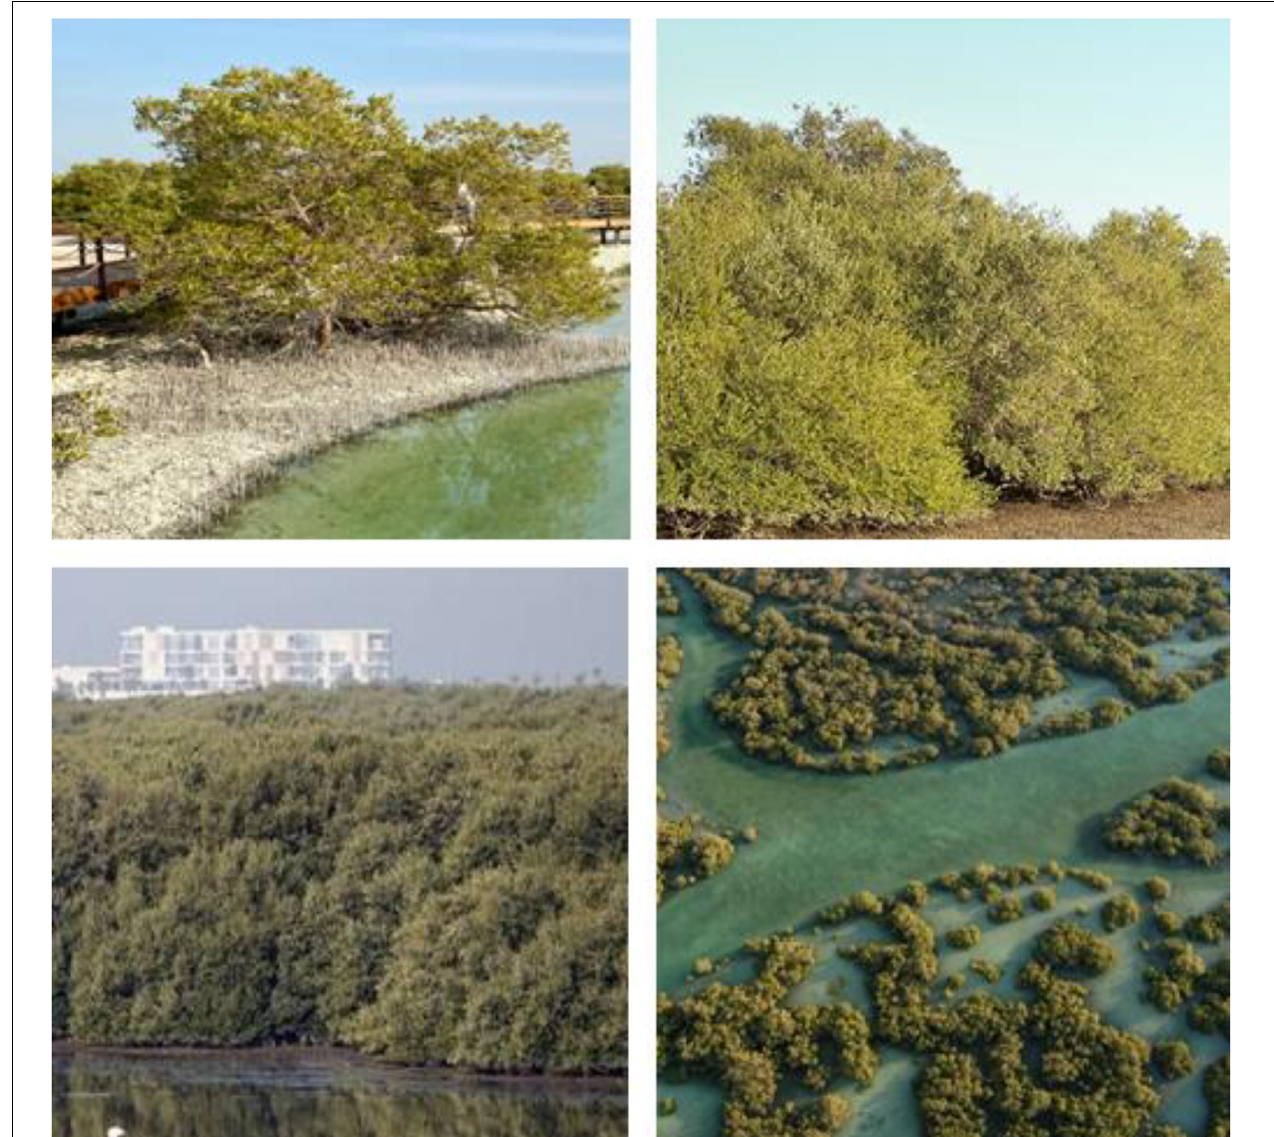
FIGURE 1 | Photos of the NUAE mangrove forests showing their spatial patterns and environment.